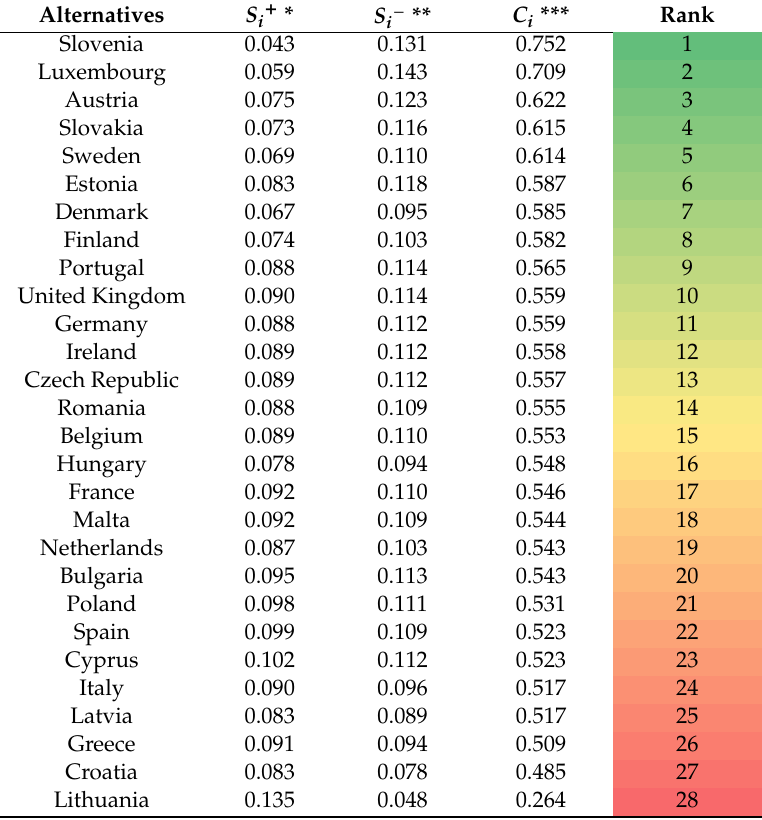
Table 5. The results of the assessment of sustainability of EU countries’ electricity sector, 2017.